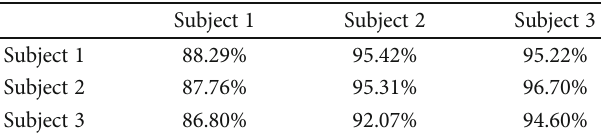
Table 3: Training/testing with half data of a subject (1 :1